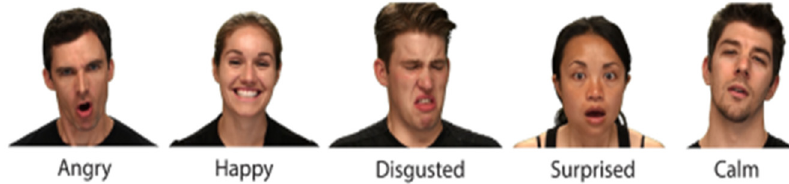
Figure 1. RAVDESS dataset specimens of emotion representations.